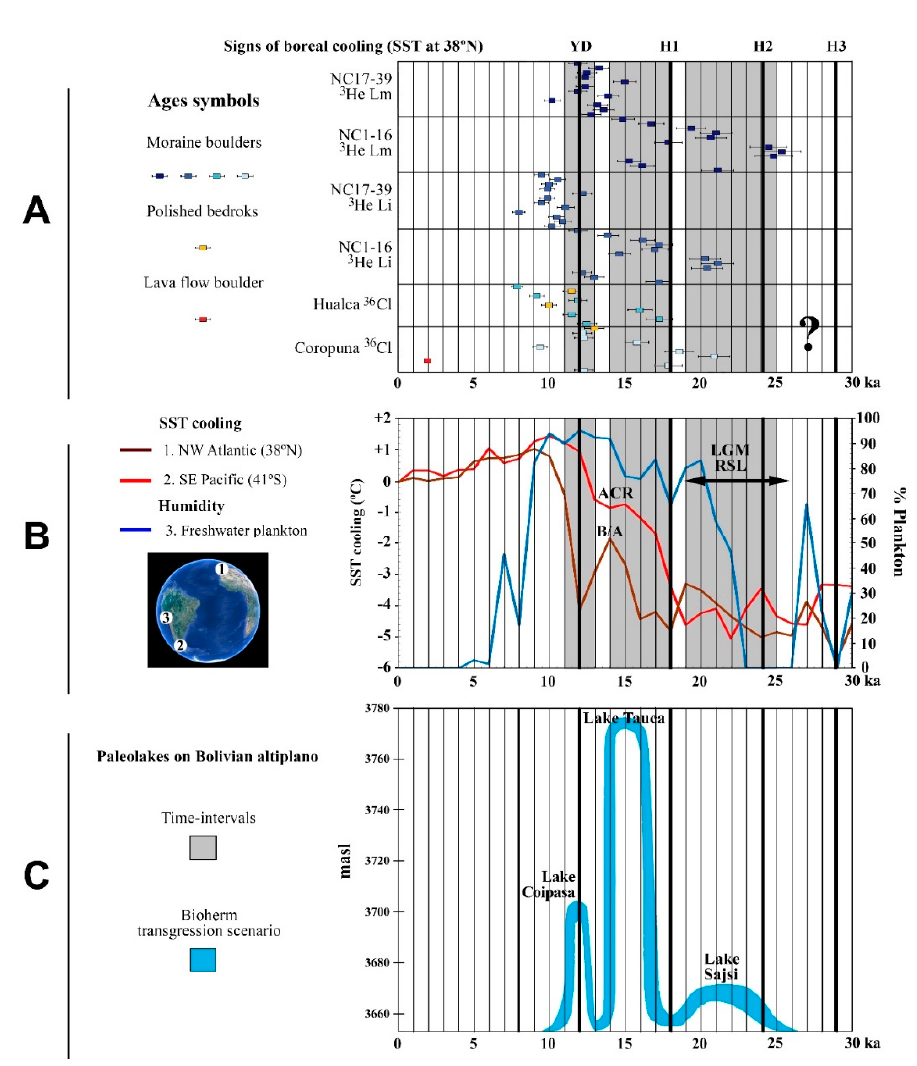
Figure 12. Timeline since 30 ka ago showing: ( A ). GLACIAL AGES. Coropuna 3 He ages, according to models Lm and Li [37,38] and 36 Cl ages from Hualca Hualca [7] and Coropuna (this work). ( B ). GLOBAL TEMPERATURE: cooling evidence in both hemispheres from alkenone sea surface temperatures. B1 (SST N ). Northeast Atlantic, westward of the Iberian Peninsula (38° N, 10° W, [109]. B2 (SST S ), Southeast Pacific, close to the coast of southern Chile (41°S, 74°W, [116]. ( B,C ). CENTRAL ANDES HUMIDITY: B3. Freshwater plankton abundance in the Lake Titicaca sediments [113]. ( C ) . Sajsi, Tauca and Coipasa paleolakes altitude, in the Bolivian Altiplano [10]. OTHER DATA: A, B and C. Gray areas: paleolakes chronology [10]. Black thick vertical lines: signals of Northern Hemisphere cold events (H3 ‐ 1 and YD) in SST N . B . Possible signals of Bølling ‐ Allerød warming (B/A) in SST N and the Antarctic Cold Reversal (ACR) in SST S . The black arrow shows the Last Glacial Maximum (LGM) from the relative sea level (RSL) [102–104].